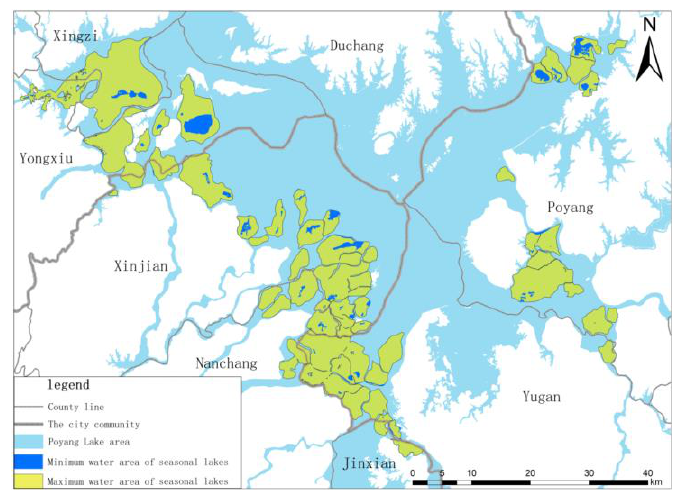
Figure 4. Comparison of spatial changes of the seasonal lakes .